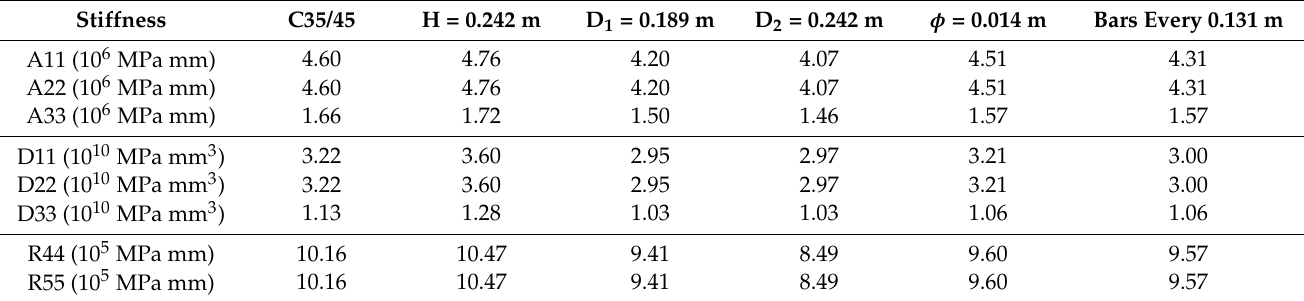
Table 6. Stiffness for RVE BD230 in case of increasing the value of individual cross-section